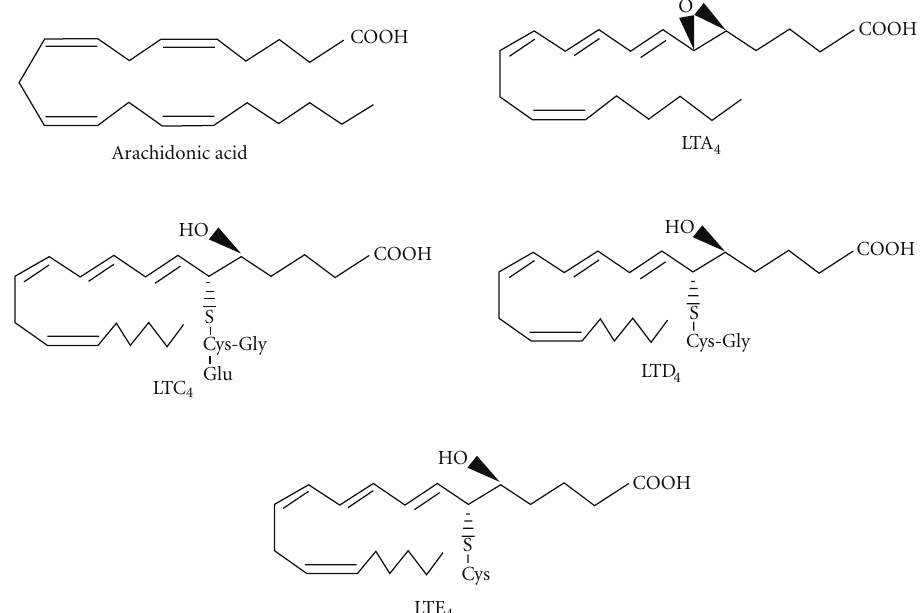
Figure 2: Chemical structures of arachidonic acid and cysteinyl